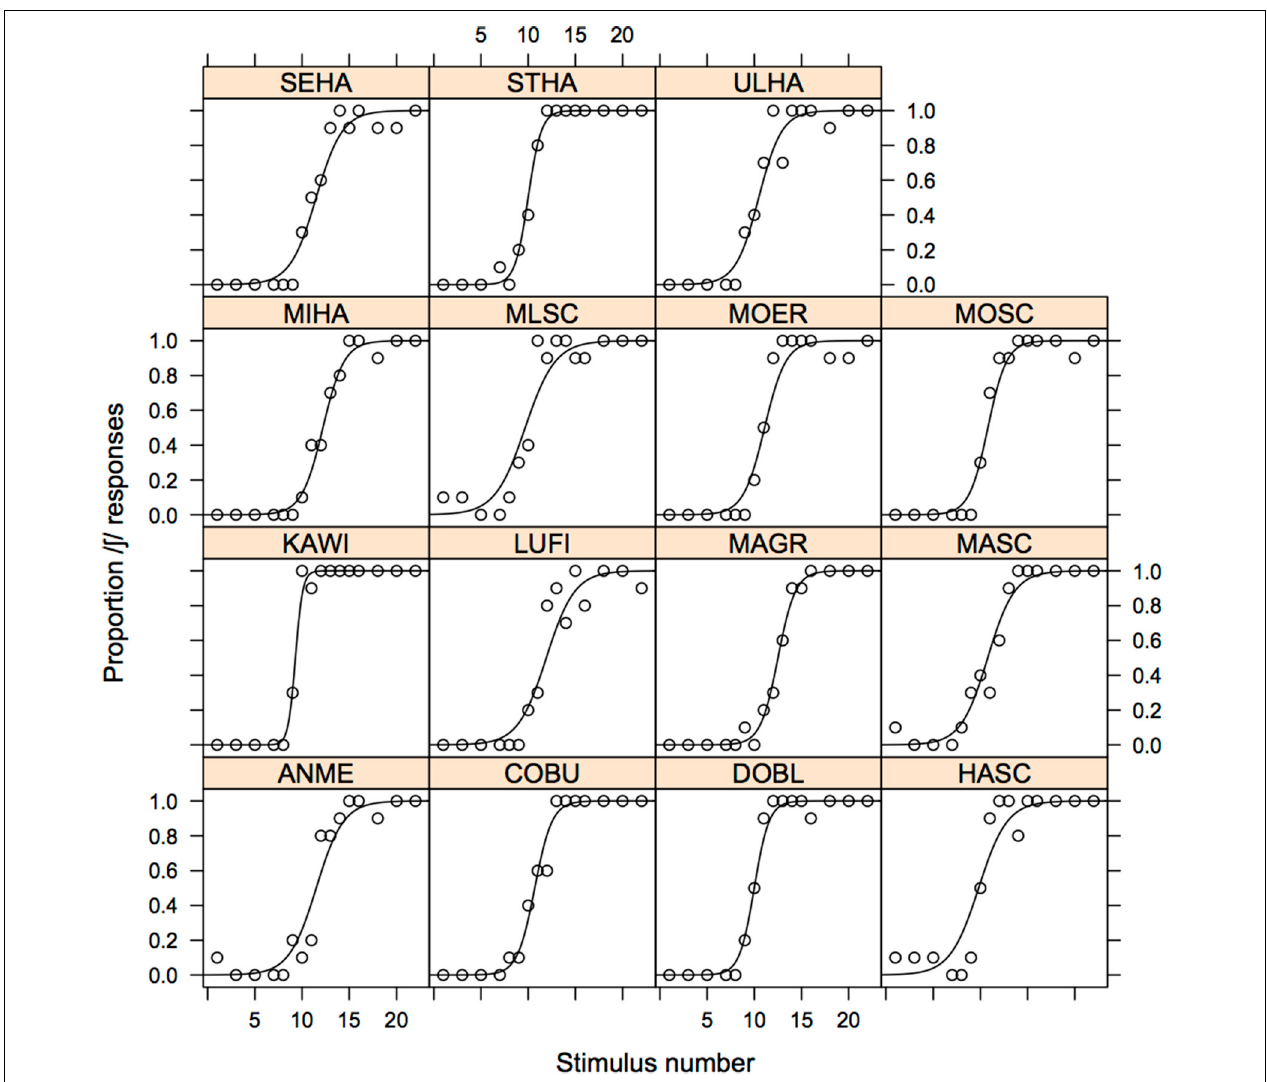
(cid:2) /-responses for the younger Augsburg group to the stimulus of the mi[s/